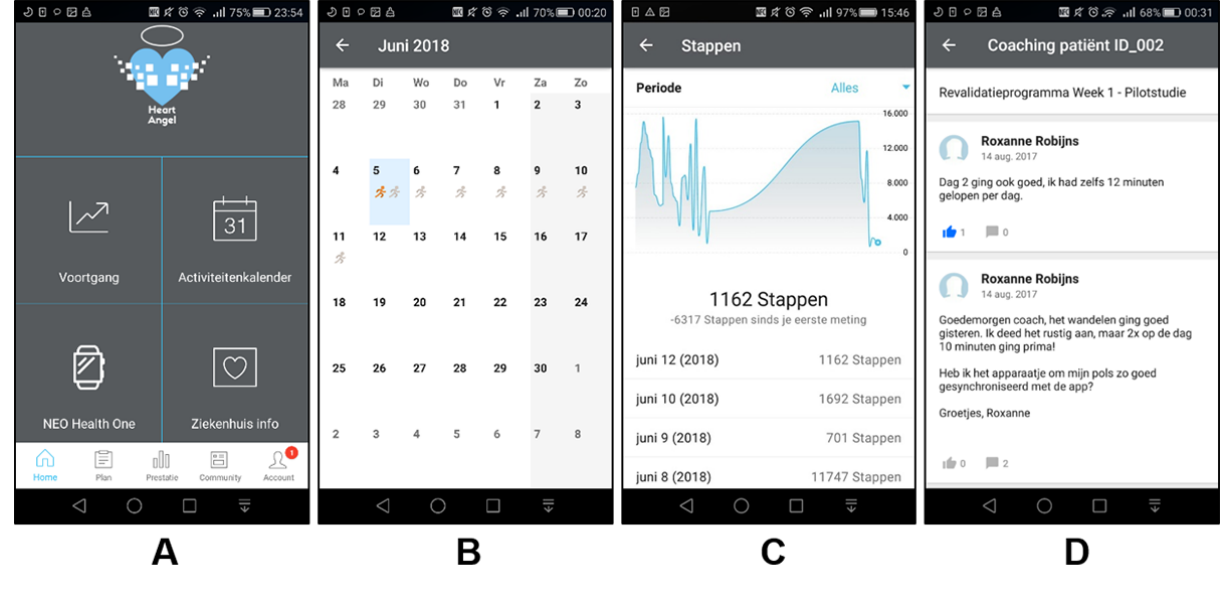
Figure 4. Screenshots of the Heart Angle mobile coaching app. (A) Homepage of the app showing the navigations to different functions. (B) Recorded walking exercise plan in the app in a calendar view. (C) Progress page showing the step data from the Neo Health One band. (D) An example of chatting between a patient and a